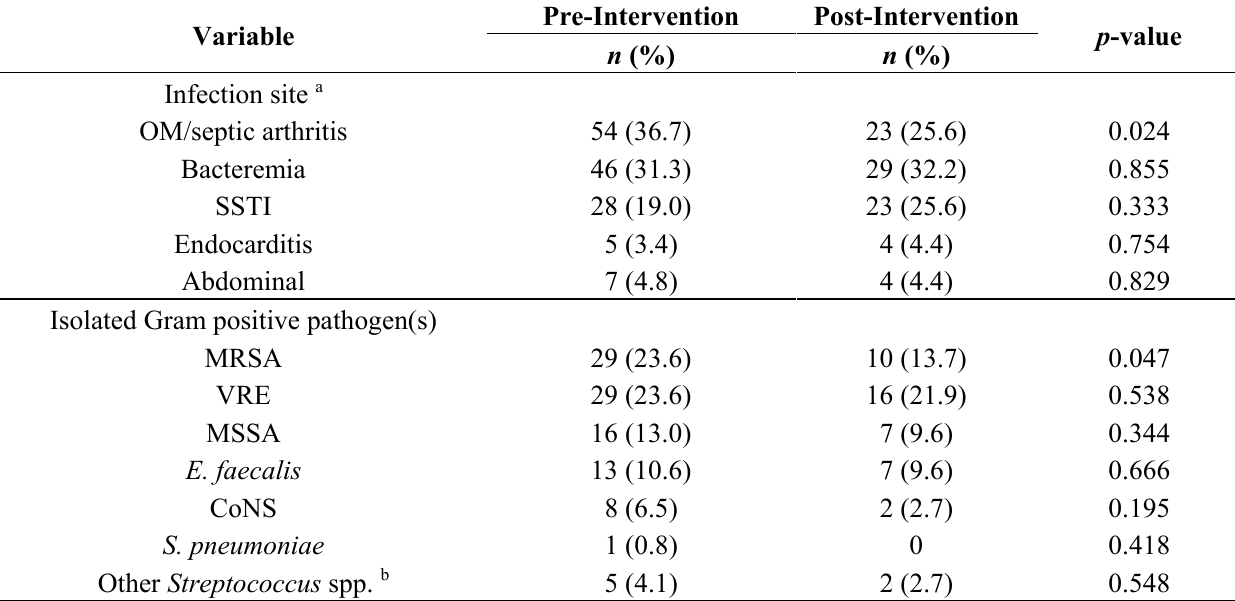
Table 3. Infection site and isolated pathogens in patients started on